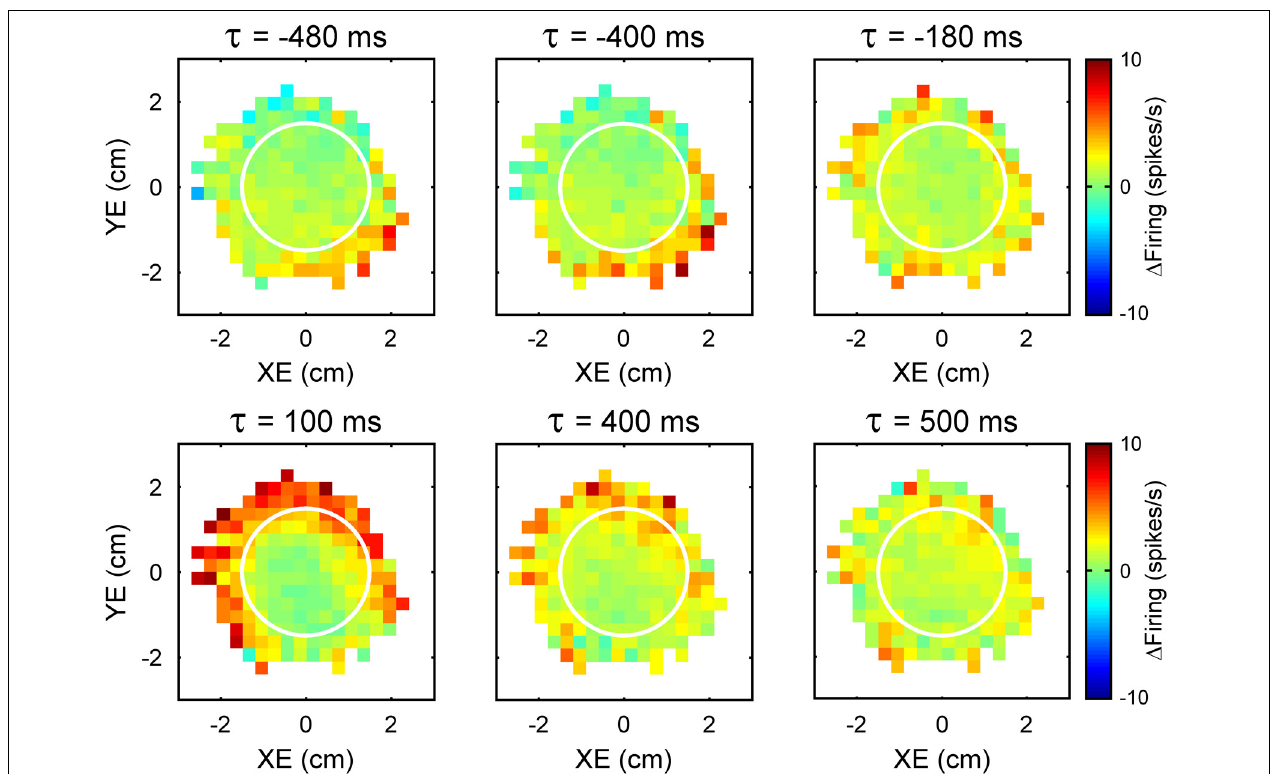
FIGURE 2 | Time course of the simple spike modulation with performance errors. Each plot is the simple spike firing in relation to XE and YE as a function of time ( τ ) from an example Purkinje cell. Negative τ